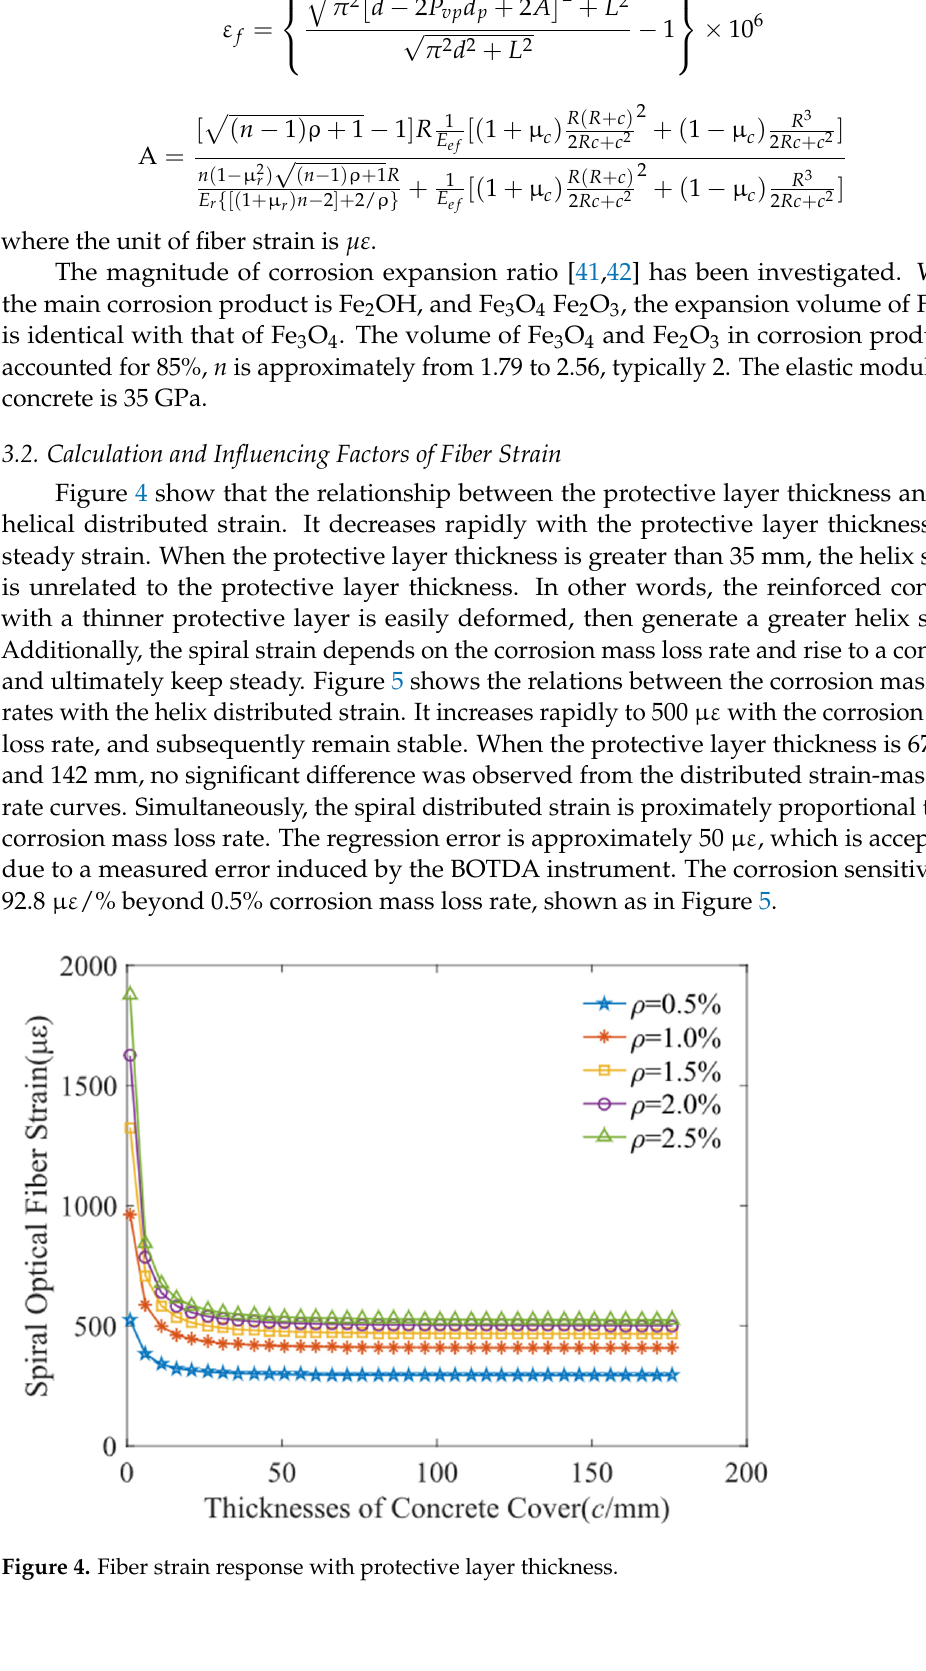
Figure 5. Fiber strain response to corrosion mass loss rate. Meanwhile, the author analyzed the influence of the steel bar diameter of 5 mm, 10 mm, 16 mm, 20 mm on helix distributed strain ( c = 67 mm, n = 2, δ = 0.001 mm), as shown in Figure 6. The optical fiber strain firstly increases with the diameter of steel bar, subsequently rise to a peak value and then drop slowly. Therefore, to attain a higher sen- sitivity, the steel bar diameter is around 25 mm. The influence of corrosion expansion coefficient on the spiral fiber optic strain is shown in Figure 7. The helical strain is mainly dependent on the corrosion expansion co- efficient n . As shown in Figure 7, fiber distributed strain with corrosion expansion coeffi- cient of n = 4 increases more sharply than that with the corrosion expansion coefficient of n = 2 at initial corrosion duration. Finally, the helix fiber strain remains basically un- changed. The reason for the above phenomena is that a greater corrosion expansion coef- ficient accelerates the filling process of corrosion products and leads to a higher compress of concrete. Thus, the corrosion rate threshold (generating an actual deformation of con- crete around the bar) is less than that the specimen with a smaller corrosion expansion coefficient. However, the corrosion expansion coefficient n is difficult to be precisely measured, and the helix fiber strain is consequently unable to be calculated by Equation (11).